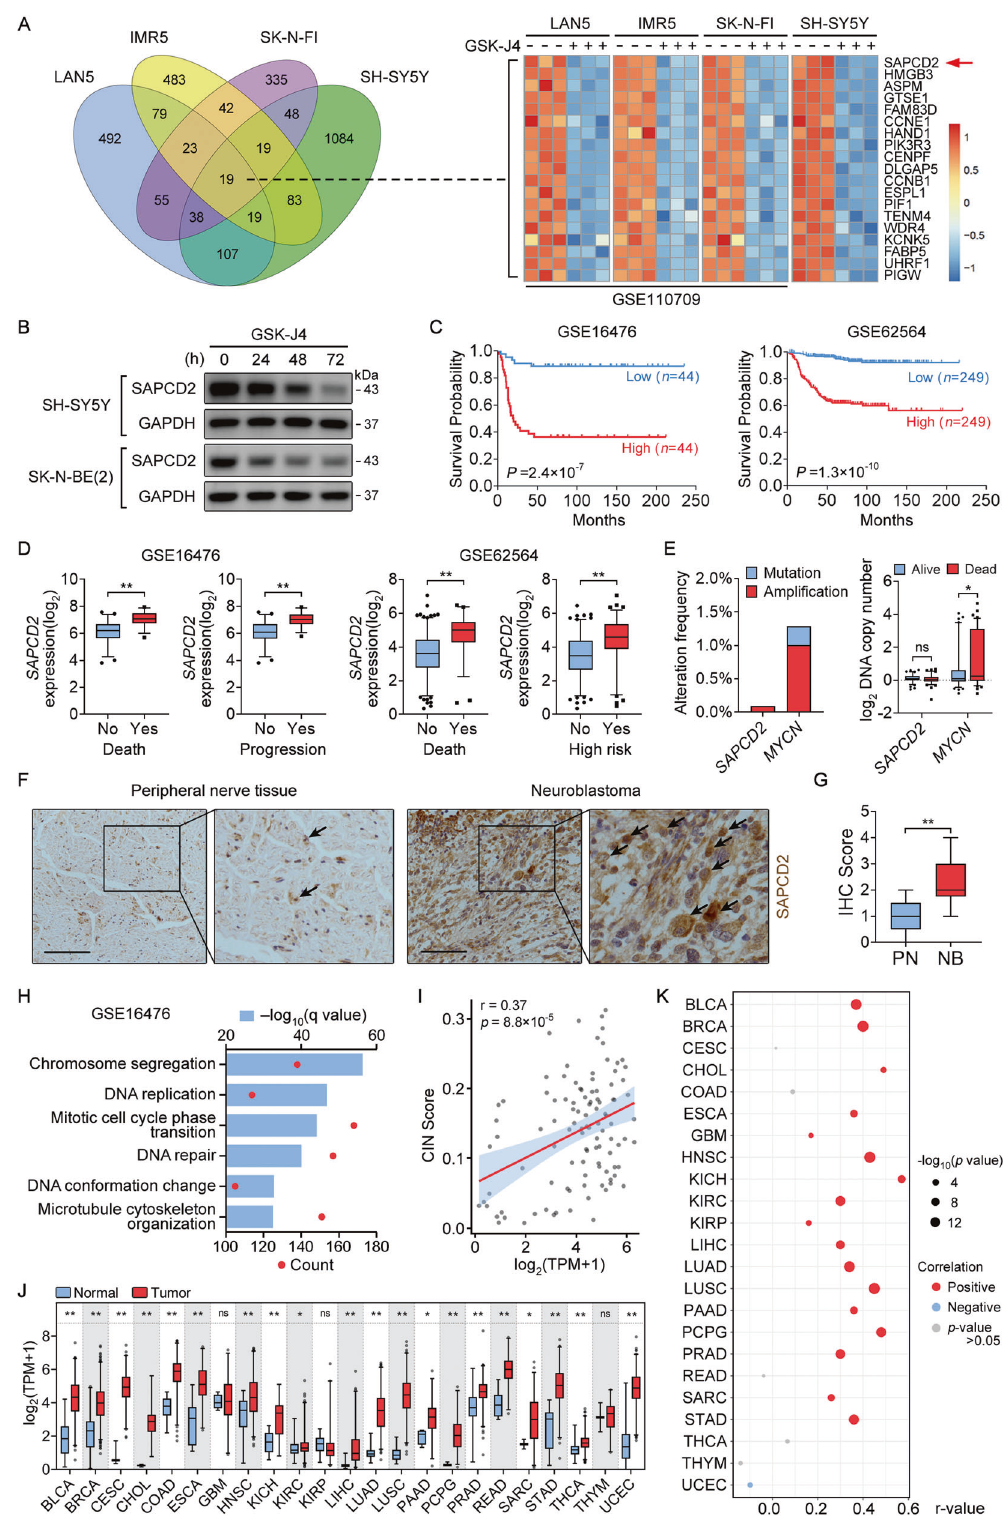
interaction with Axin1 and in some contexts might function as a tumor suppressor [14]. In our study, functional analyses in cultured NB cells and xenograft mice models demonstrated that SAPCD2 played critical roles in sustaining NB cells growth and survival.